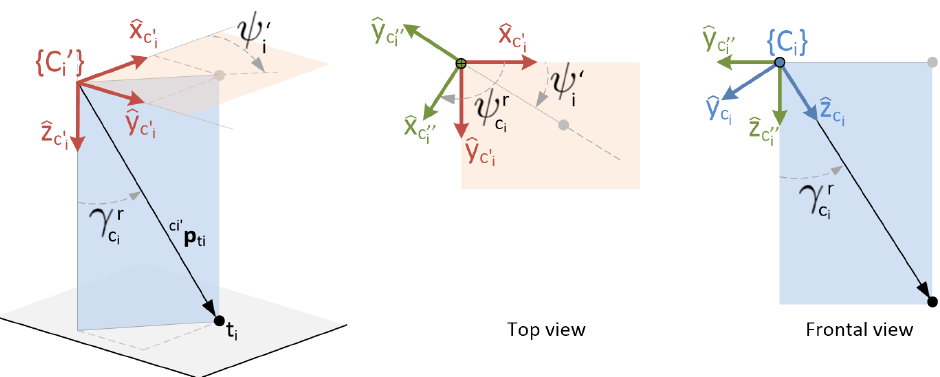
Figure 5. Rotation steps for correct aiming to a